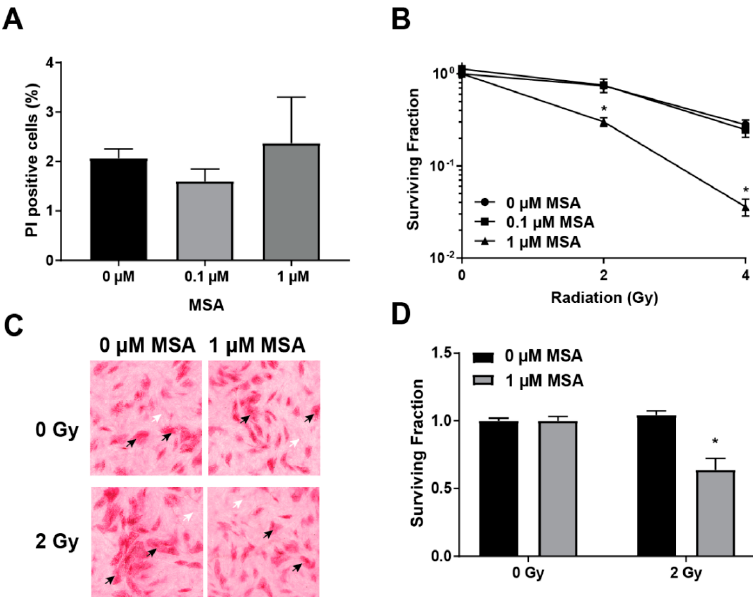
Figure 2. MSA selectively sensitizes head and neck squamous cell carcinoma (HNSCC) cells to radiation. ( A ) PI exclusion assay of normal human fibroblasts (NHF) treated with MSA 24 h. ( B ) Clonogenic assay of Cal27 cells treated with MSA 48 h before irradiation with γ -rays. ( C ) Representative images of Cal27 cells in co-cultures with NHF that were treated with MSA 48 h before irradiation with γ -rays. Black arrows: Cal27 colonies; white arrows: quiescent NHF. ( D ) Quantitation of Cal27 clonogenic survival in co-cultures of Cal27 and NHF that were treated with MSA 48 h before irradiation with γ -rays. *, statistical significance relative to 0 µ M MSA controls; p < 0.05, n =